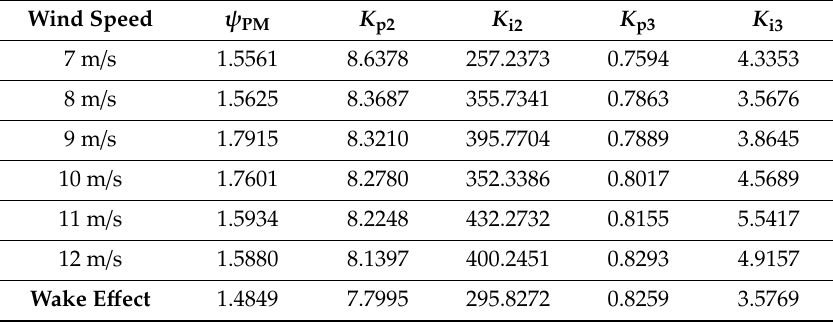
Table 6. Parameter identification results 100% online. Table 7. Results of parameters estimation 80% online.